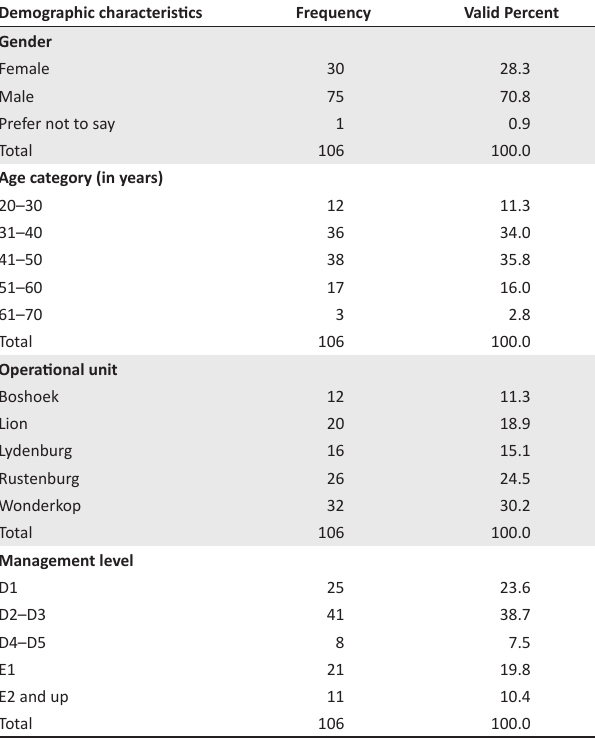
TABLE 2: Demographic characteristics of